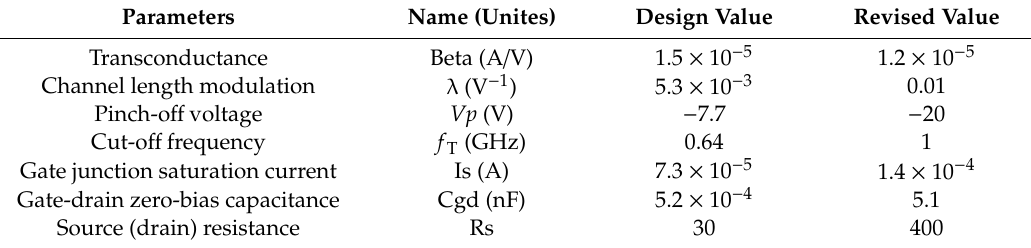
Figure 4. Transfer characteristics of JFET fabricated in the IME process (V D = 10 V). Table 1. JFET HSPICE model